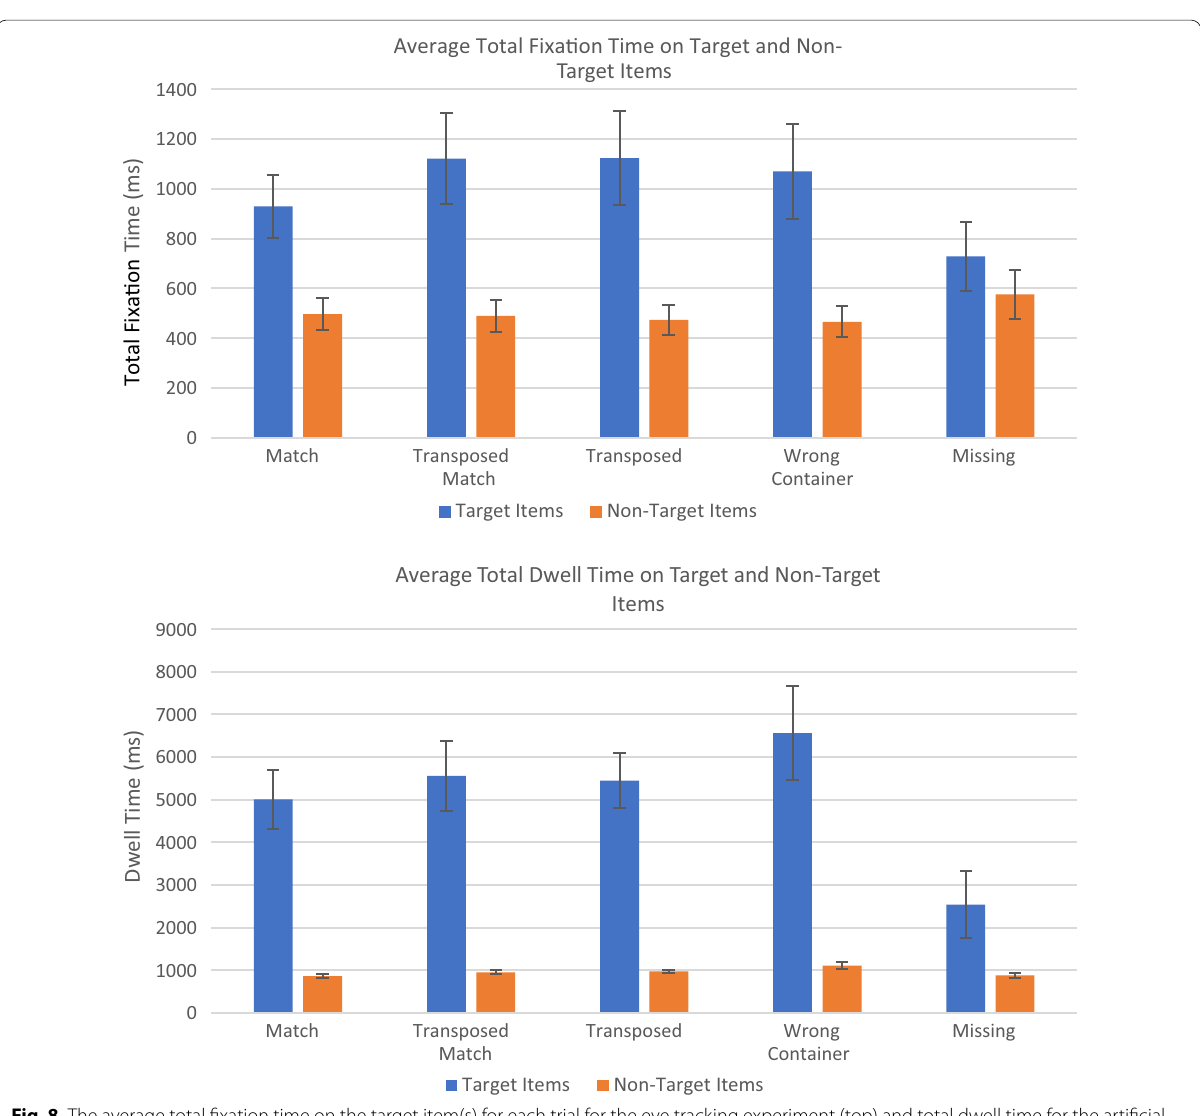
Fig. 8 The average total fixation time on the target item(s) for each trial for the eye tracking experiment (top) and total dwell time for the artificial foveation experiment (bottom). Error bars show the standard error of the